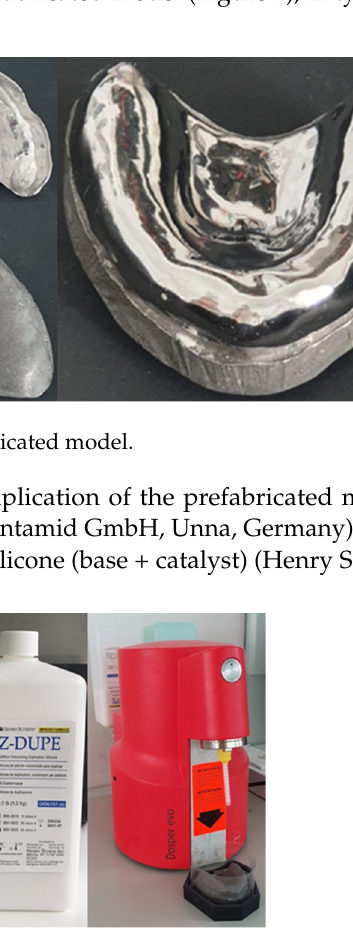
Figure 2. Z-Dupe 28 shore A silicone (base + catalyst) and Dosper Evo duplication machine. 3. The prefabricated mold was removed and the cooping was poured to type IV plaster (Figures 3 and